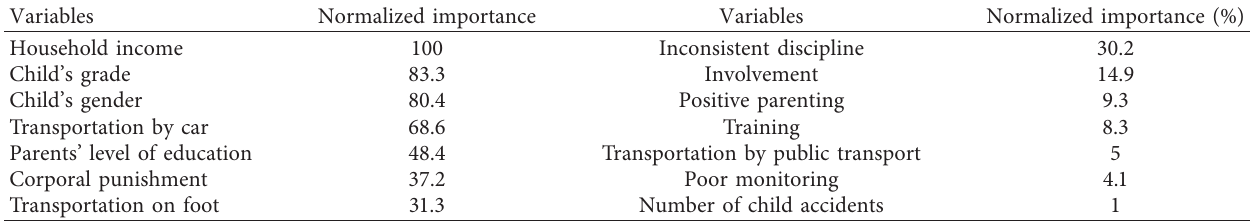
Figure 3: Decision tree of the law enforcement sign model (test Table 9: Variable significance of the law enforcement sign model.